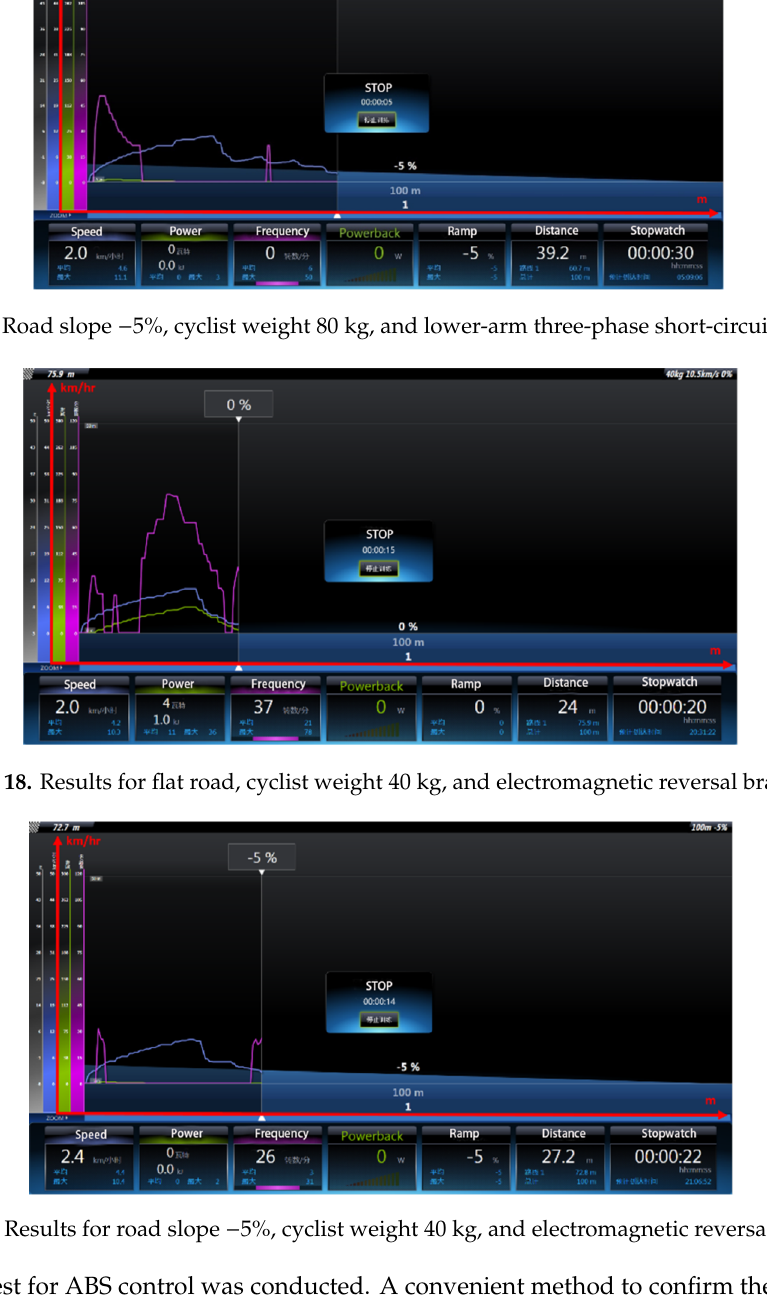
Figure 20. Results for flat road, cyclist weight 80 kg, and electromagnetic reversal braking.